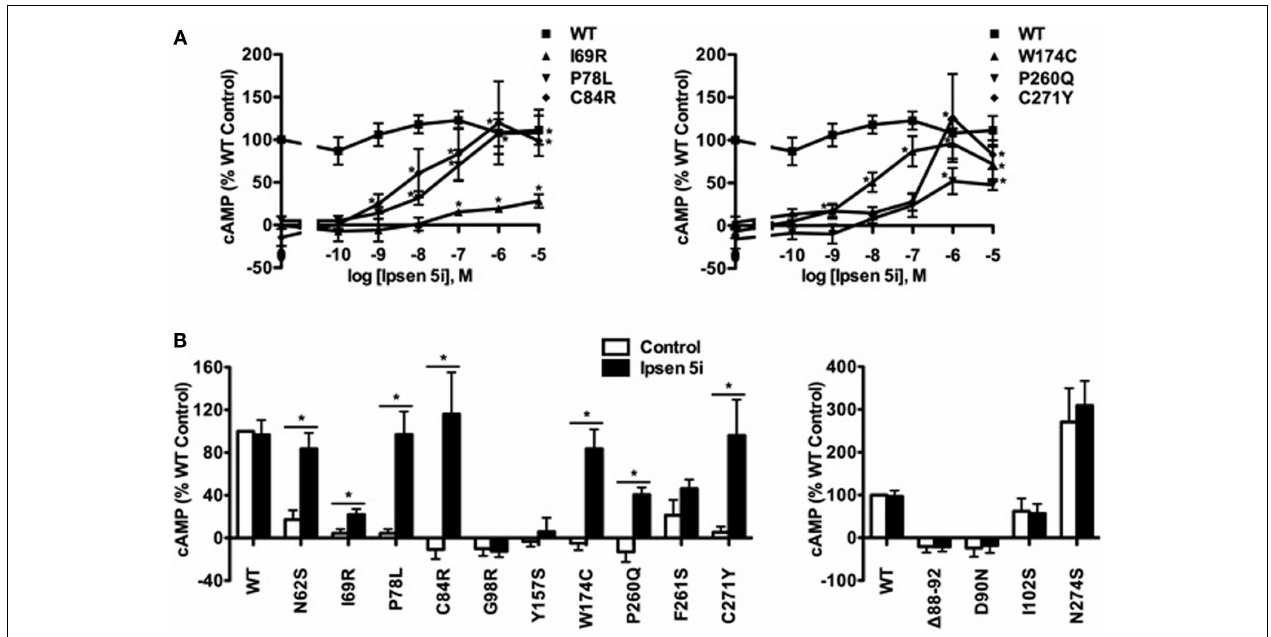
% DMSO-treatedWT cAMP production after correction of the cAMP production in cells expressing the empty vector. Data points are mean ± SEM of at least three independent experiments. See the legend to Figure 5 for other details.